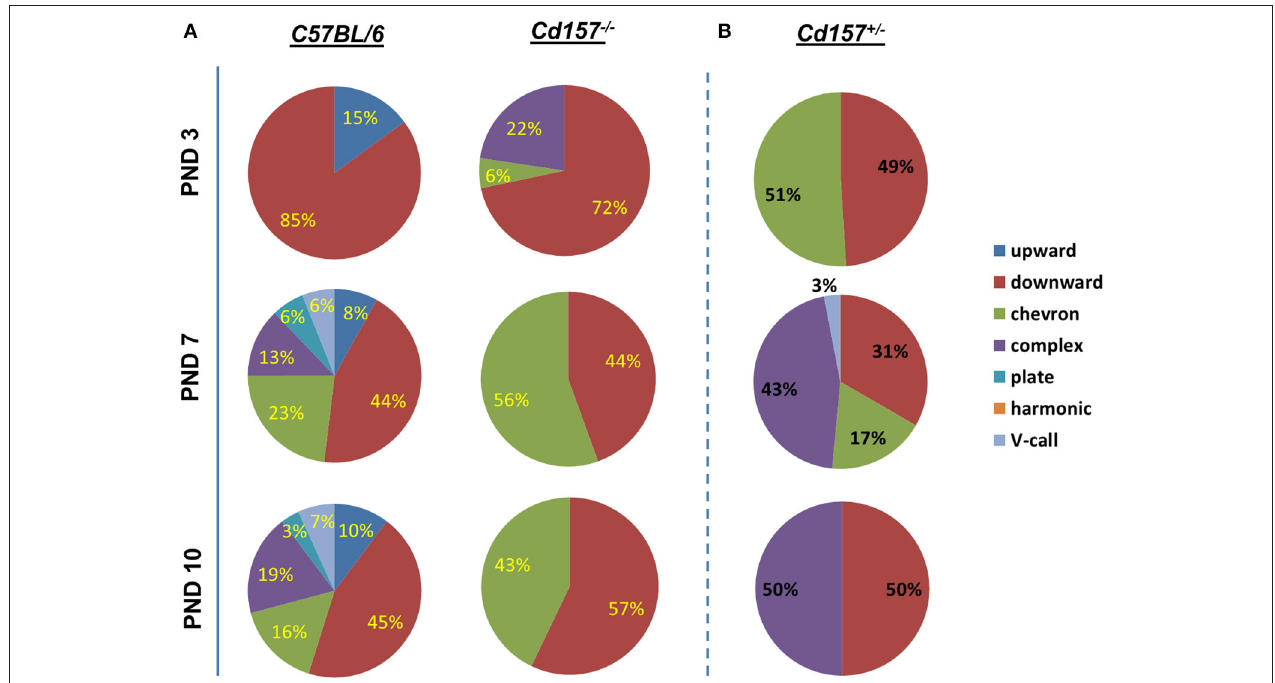
FIGURE 2 | Call category variations in USVs emitted pups with Cd157 gene deletion at PNDs 3, 7, and 10. Percentages of call syllable were calculated in Cd157 + / + (A) , Cd157 − / − (A) , and Cd157 + / − (B) mouse groups as the number of calls in each category for each subject/total number of calls analyzed in each subject. (Number of pups used = 15–20, number of calls analyzed = 100–120). The calculated data of calls are presented in the Supplementary Table 1